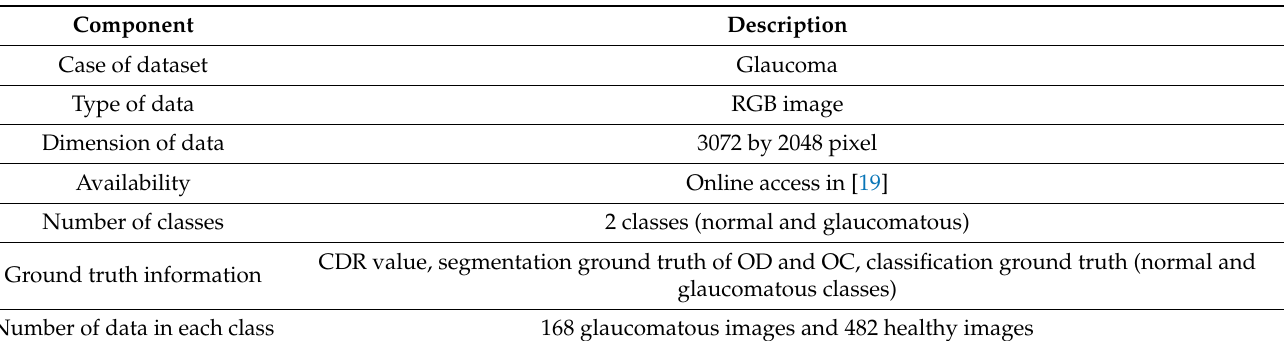
Table 1. Characteristic of ORIGA-light